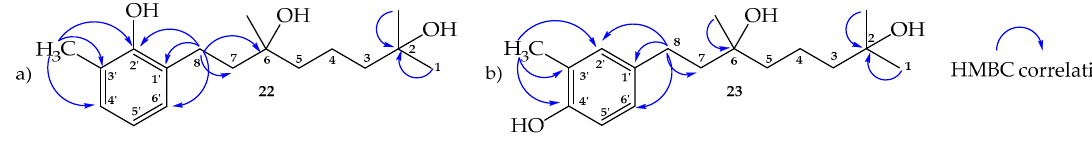
Figure 6. Main 2D HMBC observed correlations for: ( a ) Compound 22 ; ( b ) Compound 23 .